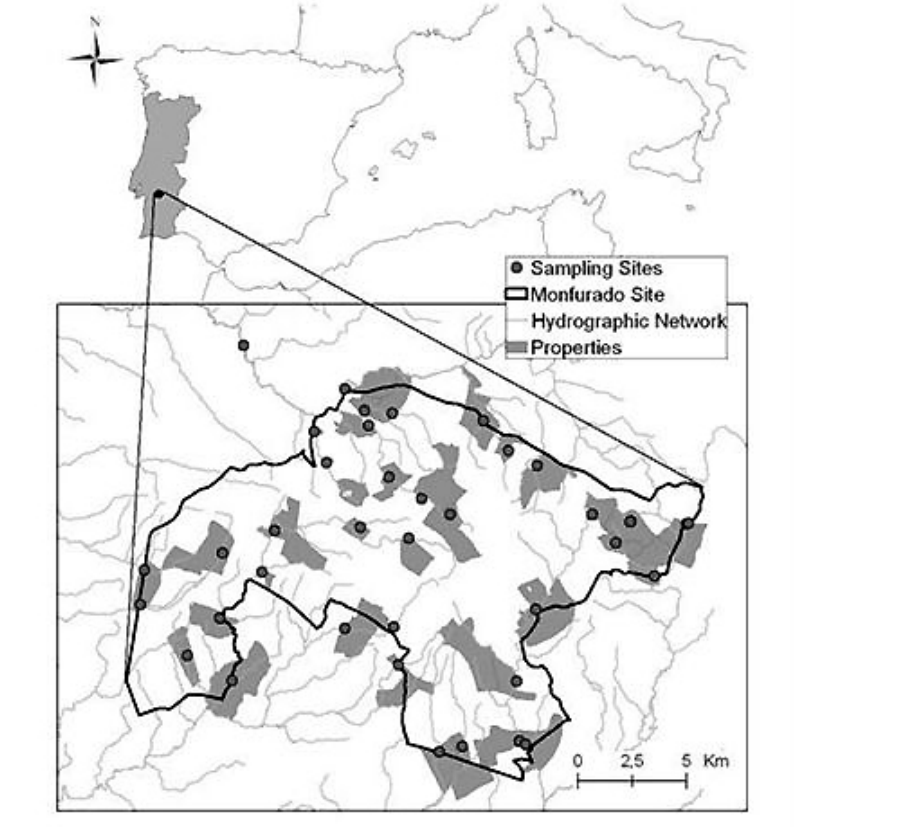
Fig. 1. Streams, sampling points, and private properties including the sampling points in the Natura 2000 Site of Monfurado located in Alentejo,